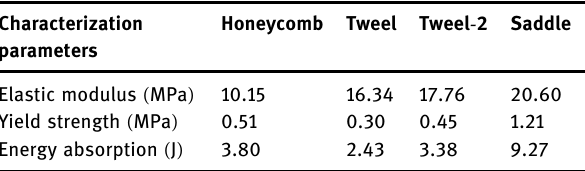
Table 1: Vertical bearing performance parameters of the four non